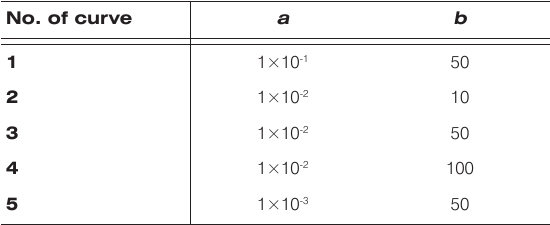
treatment of the adjustment of equilibrium isotherm, including the assumption of temperature-independence of some of quantities, minimizes the correlations between the best-fit parameters. It seems that taking another set of experimental data into consideration should also lead to a successful description. However, in the literature it is not easy to find data including both the single-gas equilibrium and kinetic